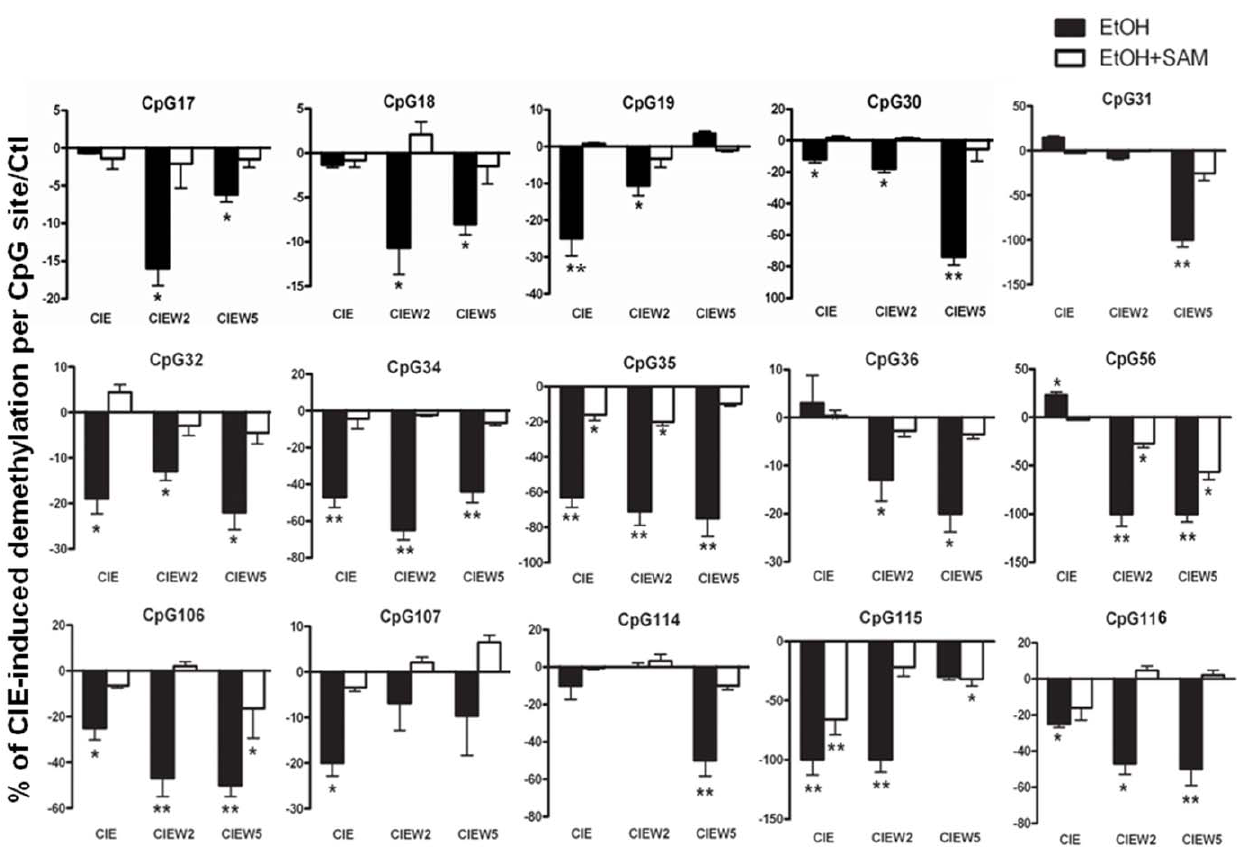
Figure 4. Quantitative analysis of DNA demethylation levels in the CpG sites following CIE treatment with or without SAM. Genomic DNA isolated from control and CIE-treated cortical neuronal cultures was bisulfite-treated and pyrosequencing analyzed. The 15 individual graphs show the detailed changes in percentage of CpG demethylation following CIE treatment and withdrawal with or without SAM in the indicated CpG sites, which are indicated with arrows in Figure 3. The values in negative are defined in this study to represent demethylation. Results are presented as the mean percentage of demethylation verse to the level of control (zero) 6 SEM; *, p , 0.05; **, p , 0.01 compared with respective control levels.